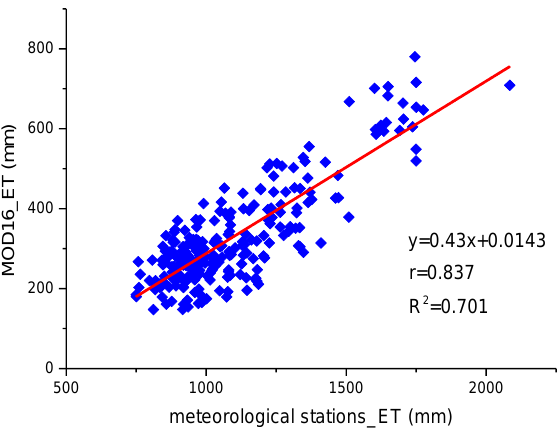
Figure 2. Correlation between MOD16 ET and meteorological station ET data. The red line represents the best fitting line. The point represents the actual ET of 12 meteorological stations from 2001 to 2020.